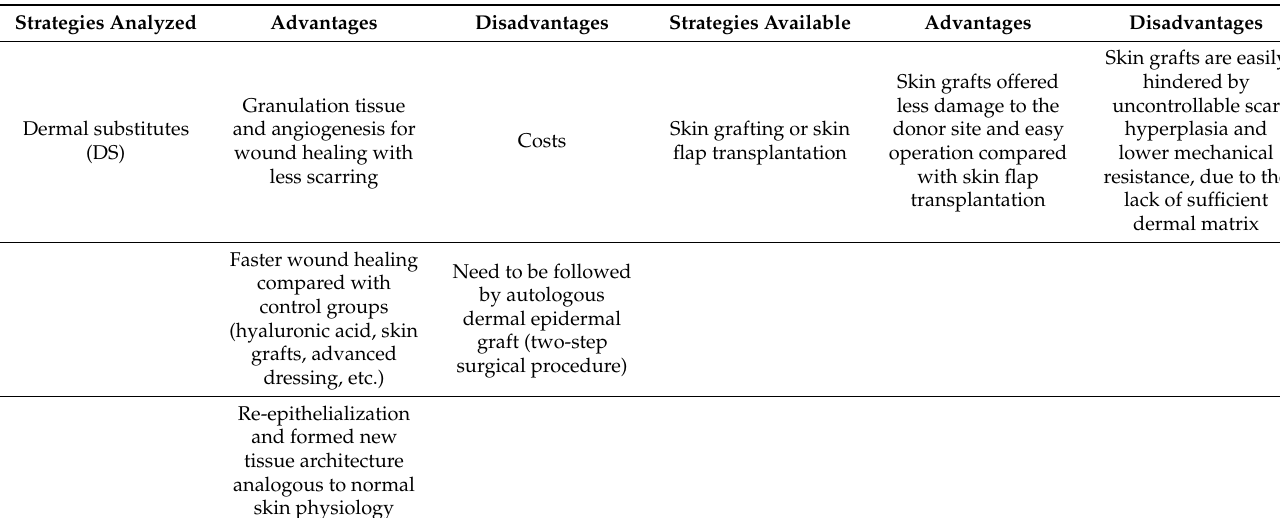
Table 1. Details of the studies analyzed compared with the strategies available, describing their advantages and disadvan-